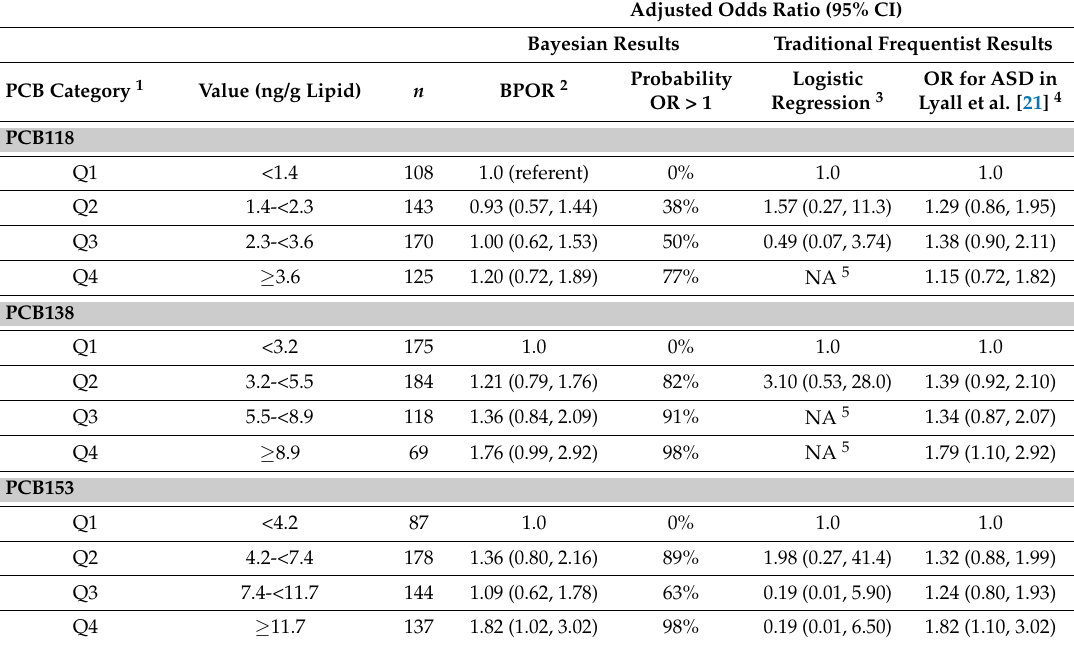
Table 4. Bayesian Predictive Odds Ratios (BPORs) for the relation between mother PCB levels (quartiles) and child autistic behaviours defined by an SRS > 60 threshold, in MIREC study participants, Canada, 2008–2011 ( n =